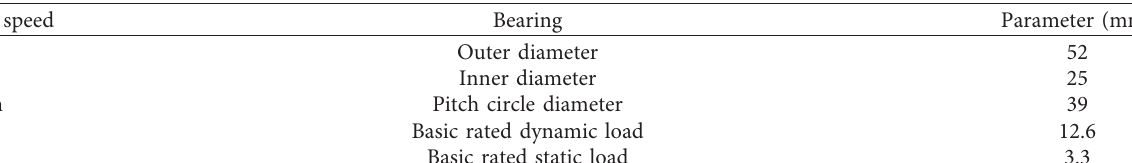
Figure 3: The bearing fault experiment Table 1: Experimental parameters.